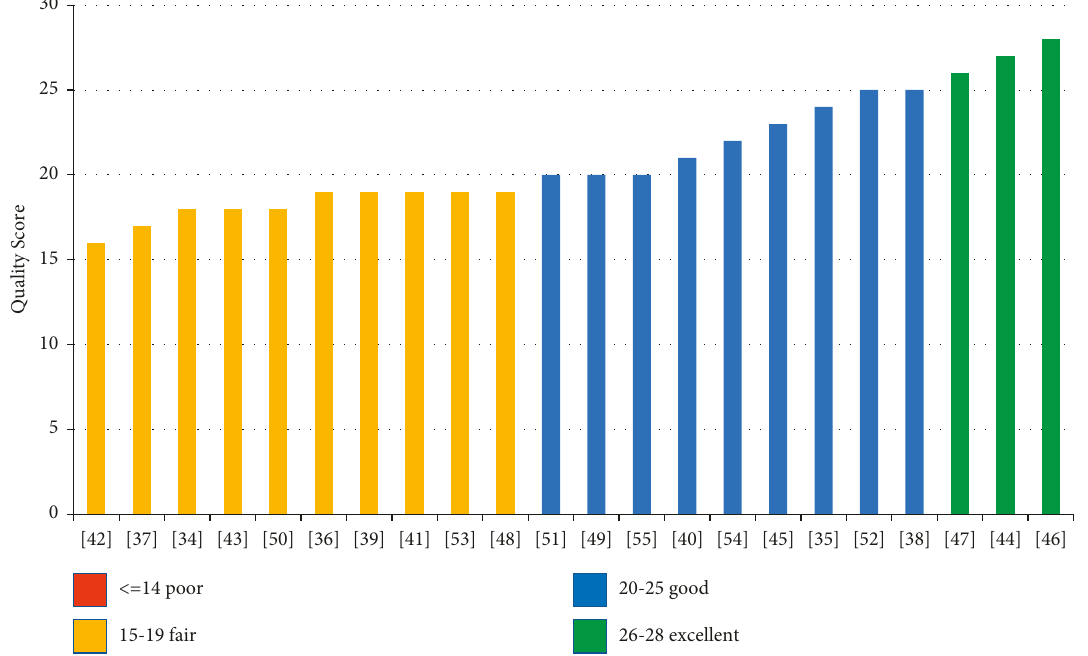
Figure 2: Quality scores of papers included for review (based on Downs and Black assessment tool). Table 1: Reported maternal outcomes on Se